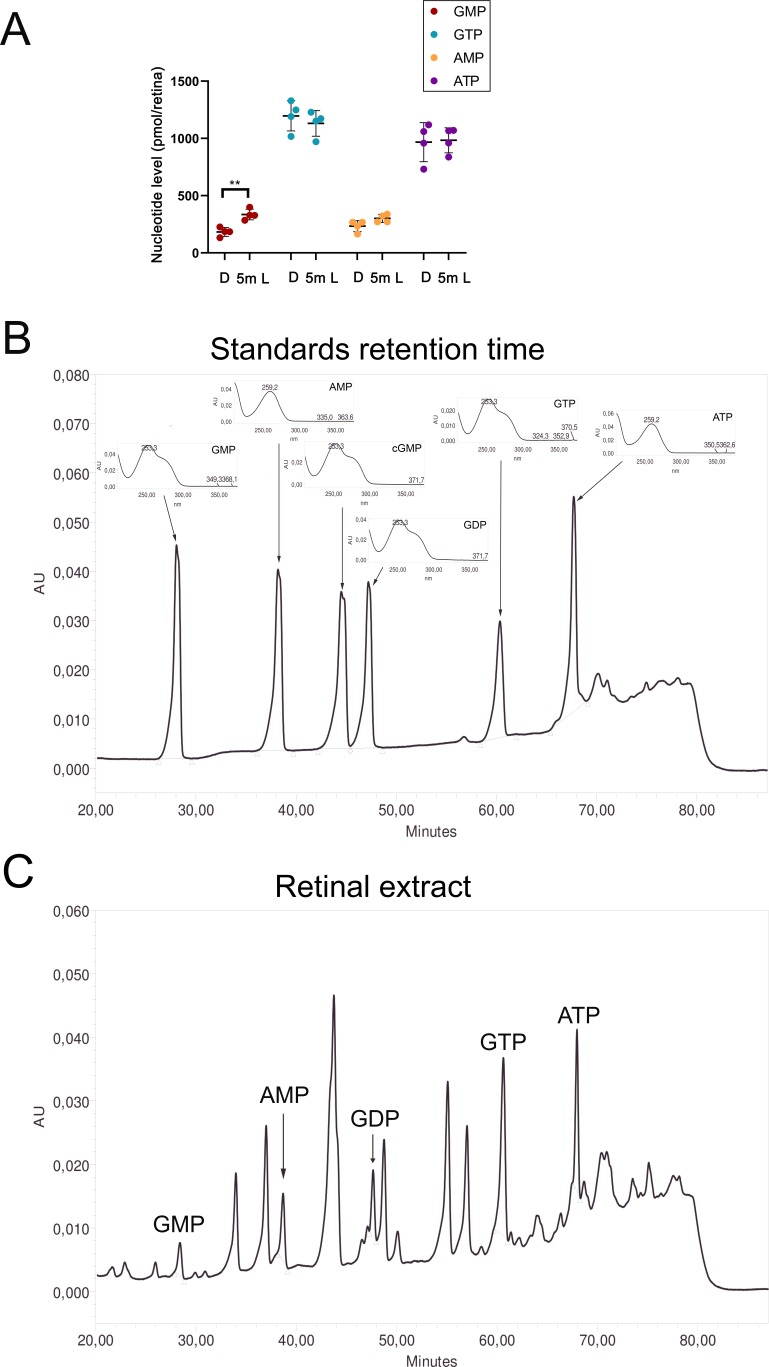
HPLC determination of nucleotide levels in dark-adapted or light-exposed in situ retinas.(A) Nucleotide levels (pmol/retina) in whole retinas obtained from dark-adapted mice that were maintained in DMEM in situ for 5 min, either in darkness or exposed to 2,000 lux white light. Note that GMP levels increased with light exposure, while GTP and ATP levels were maintained. Individual values and the Mean ± STDEV is indicated (4 biological replicates). Unpaired t-test for GMP values in dark and light resulted in p=0.002; while other nucleotides showed not significant changes between dark and 5 min light. Note that GTP levels were higher than ATP levels in the retina, both in dark and light conditions. (B) Chromatogram of a mix of nucleotide standards, showing each nucleotide retention time and typical spectral sensitivity. (C) Representative chromatogram of a retinal extract showing the retention time and relative abundances of the different nucleotides. cGMP was below detection in retinal extracts.